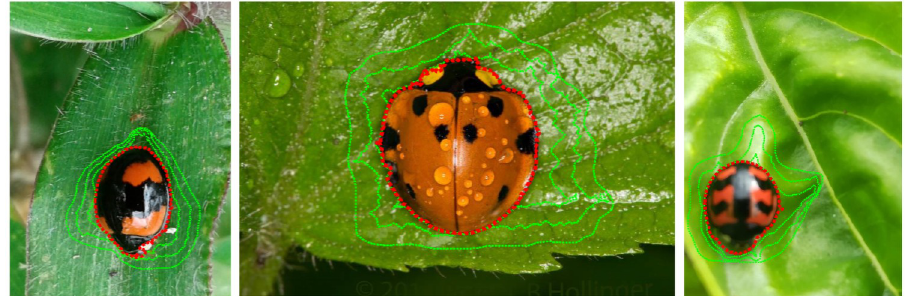
Fig 1. Deformation example of the Chan-Vese active contour curve (green lines) until reaching the ladybird beetles boundary (red line) on the image.